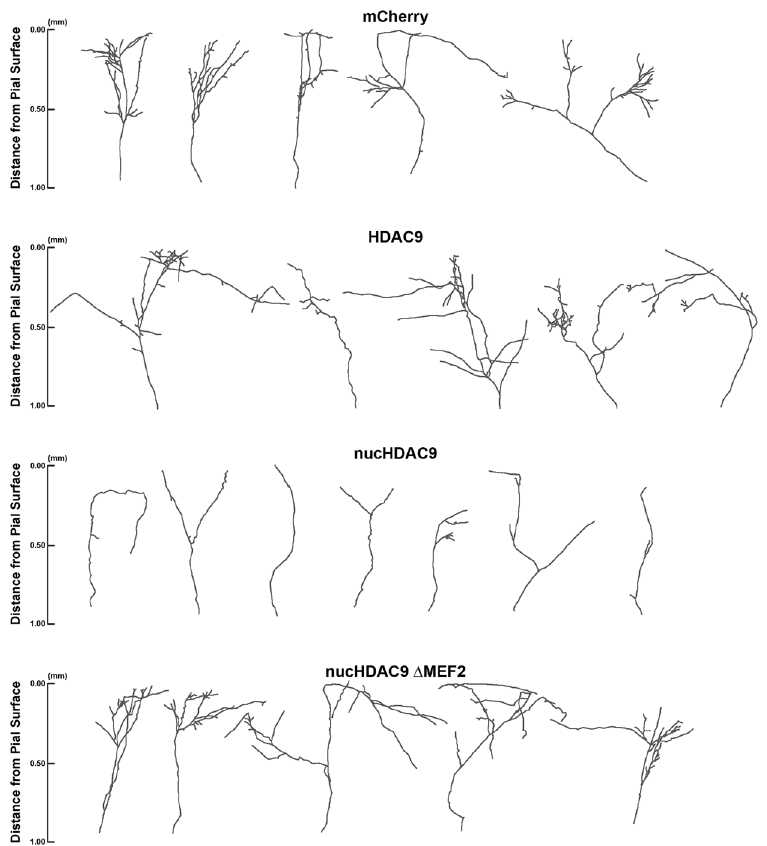
Figure 4. Disruption of HDAC9 translocation and MEF2 interaction affect TC axon branching. Representative tracings of control and mutant HDAC9 transfected axons. Thalamic cells were electroporated with only mCherry to observe control TC axon branching. To examine the effect of the HDAC9 mutants, mCherry was co-transfected with either of HDAC9, nucHDAC9, or nucHDAC9 Δ